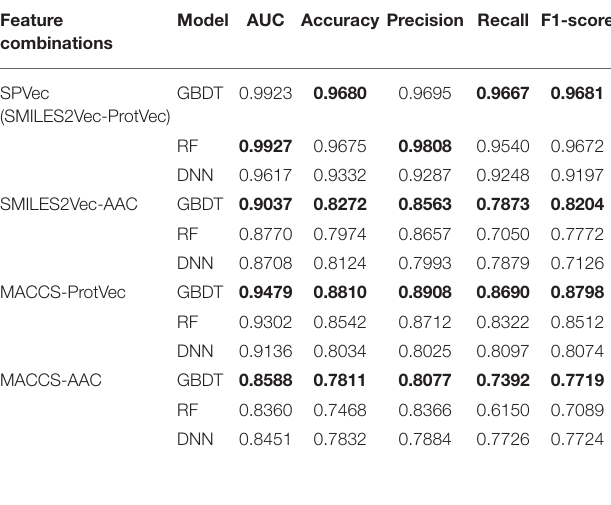
TABLE 2 | Results of classification performance of four feature combinations using three classifiers on BindingDB via 10 × 5-fold cross-validation, with the highest scores highlighted in the bold font.